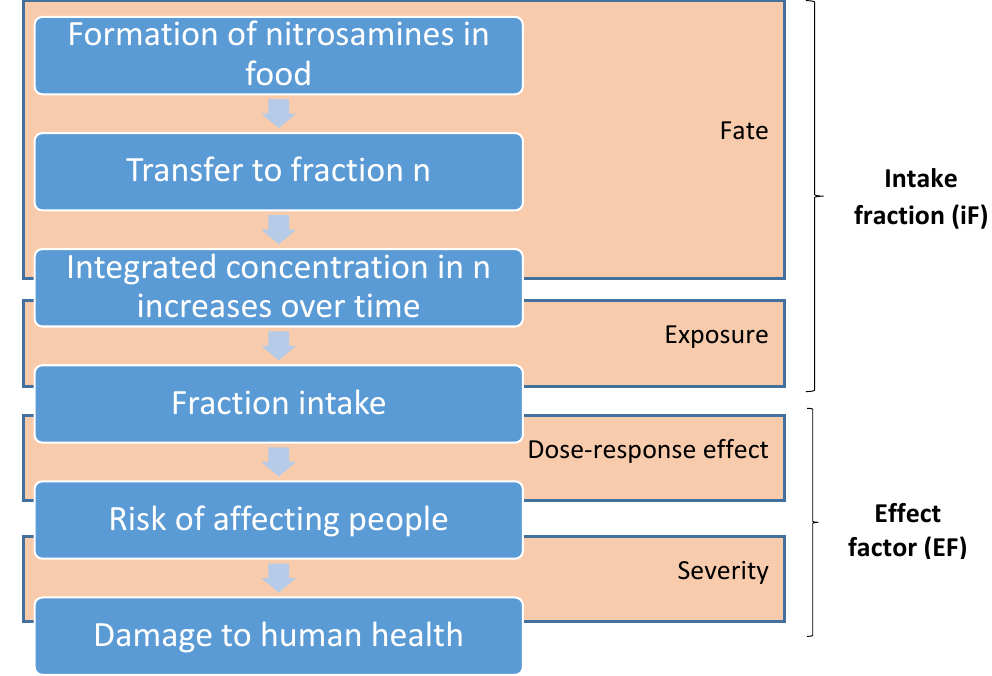
Figure 3. Causality chain of the potential toxicity of nitrosamines via the ingestion of food (inspired by Jolliet et al. 2010